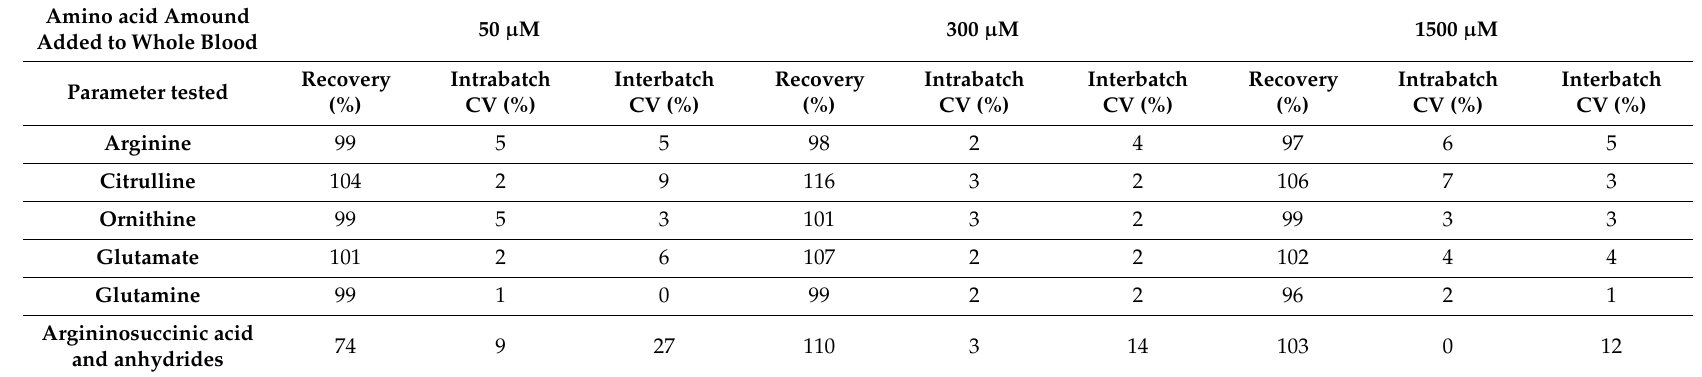
Table 1. Recovery, intra- and inter-batch coe ffi cient of variations for each